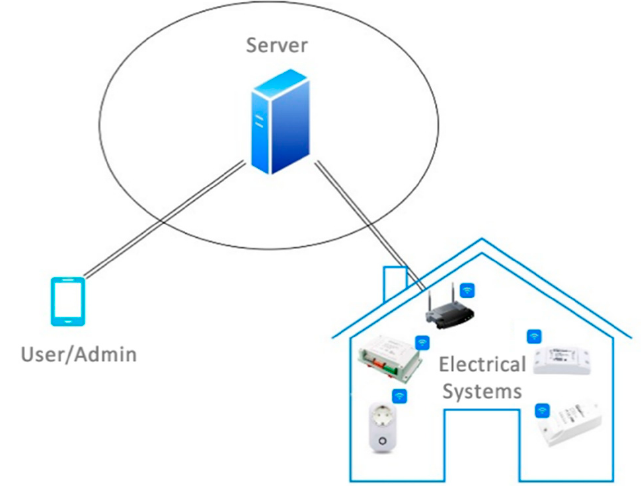
Figure 7. IoT system architecture. Table 6. Technology comparison for short/medium coverage